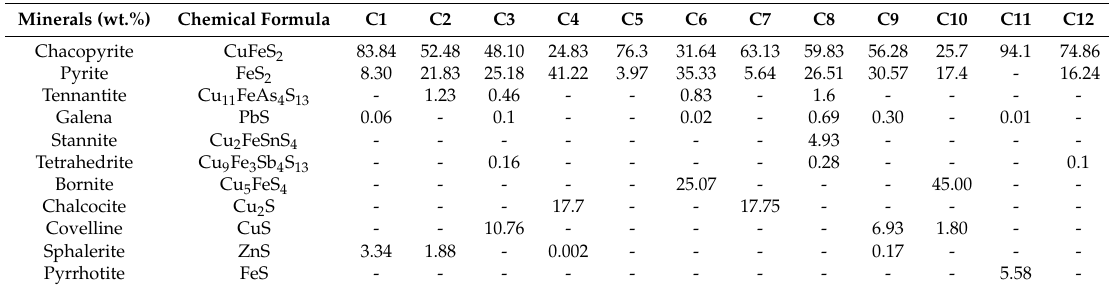
Table 4. Mineral composition of the concentrates studied.